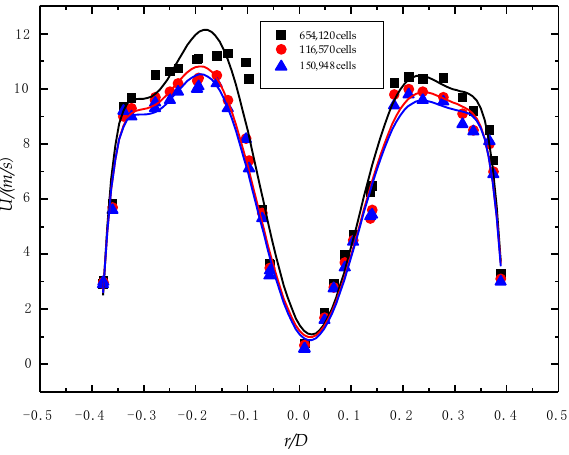
Figure 4. Velocity distribution in the different sections.